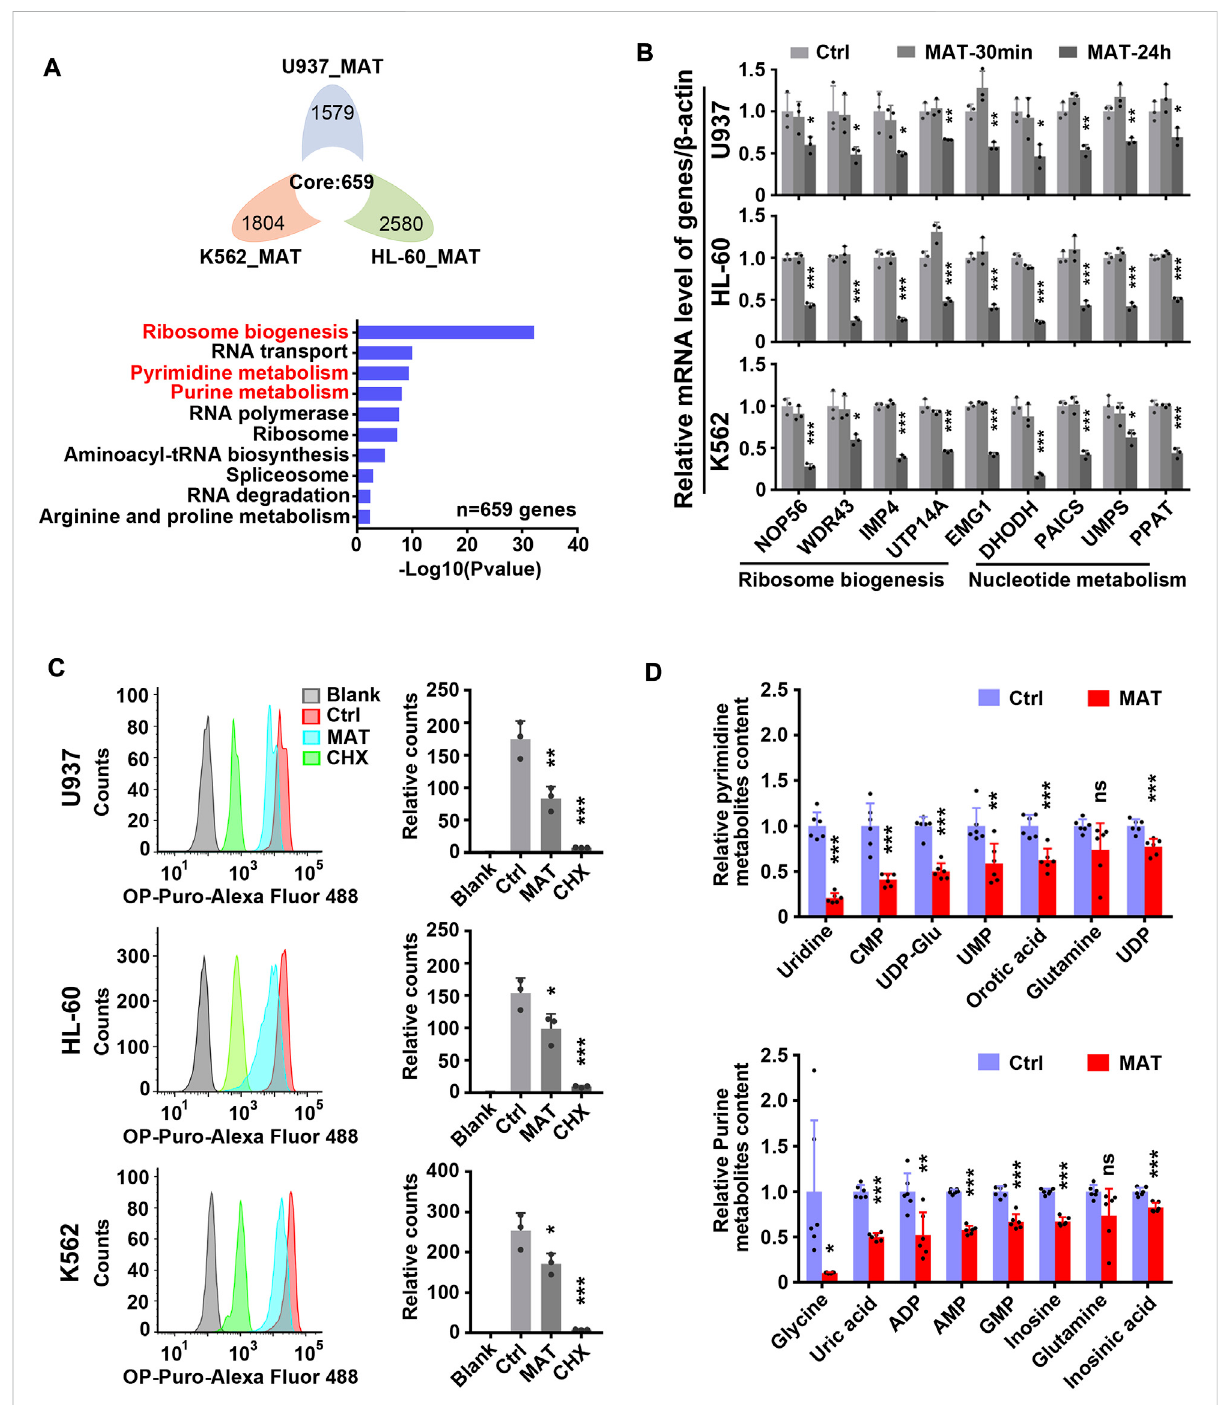
FIGURE 4 Matrine suppresses ribosome biogenesis and nucleotide metabolism. (A) The intersection and KEGG enrichment analysis of genes down- regulated (|Foldchange| ≥ 1.5, padj < 0.05) in RNA-Seq of 3 cell lines treated with 0.8 mg/ml matrine for 24 h. Flower plot (above) and KEGG enrichment analysis (below) are shown. (B) QPCR analysis of representative ribosome biogenesis and nucleotide metabolis-related genes in 3 cell lines treated with 0.8 mg/ml matrine for 30 min and 24 h. (C) Measurement of global nascent protein synthesis by means of O-Propargyl- puromycin (OP-Puro) incorporation and fl ow cytometry in 3 cell lines treated with 0.8 mg/ml matrine for 24 h or 50ug/mL CHX for 2 h. Representative image (left) and quanti fi ed level of global protein synthesis (right) are shown. (D) LC-MS/MS metabolomic analysis (HILIC) for pyrimidine and purine metabolism-related substances of U937 cell line treated with 0.8 mg/ml matrine for 24 h. Data are shown as mean ± SEM of three independently triplicates (B,C) or six independently triplicates (D) . Signi fi cance determined for each cell line treated with matrine or CHX vs. Ctrl.* p < 0.05,** p < 0.01,*** p < 0.001,unpairedt-test.CMP,cytidine5 ′ -monophosphate;UDP-Glu,uridine5 ′ -diphosphoglucose;UMP,uridine5 ′ - monophosphate; UDP, uridine 5 ′ -diphosphate; ADP, adenosine 5 ′ -diphosphate; AMP, adenosine 5 ′ -monophosphate; GMP, guanosine 5 ′ -